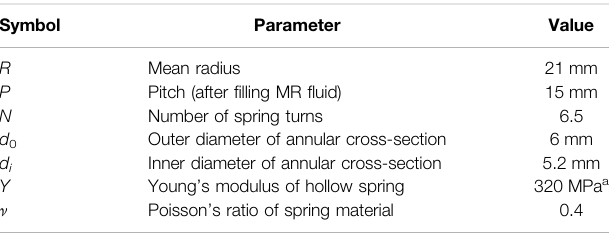
TABLE 1 | Parameters of the hollow spring.